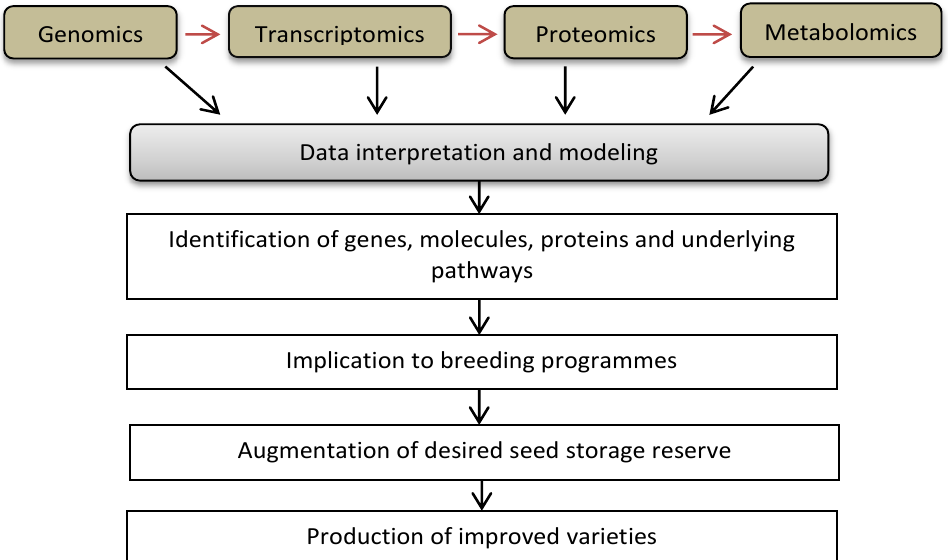
Figure 4. Omics approaches for the production of improved varieties in terms of the augmentation of seed storage reserves.